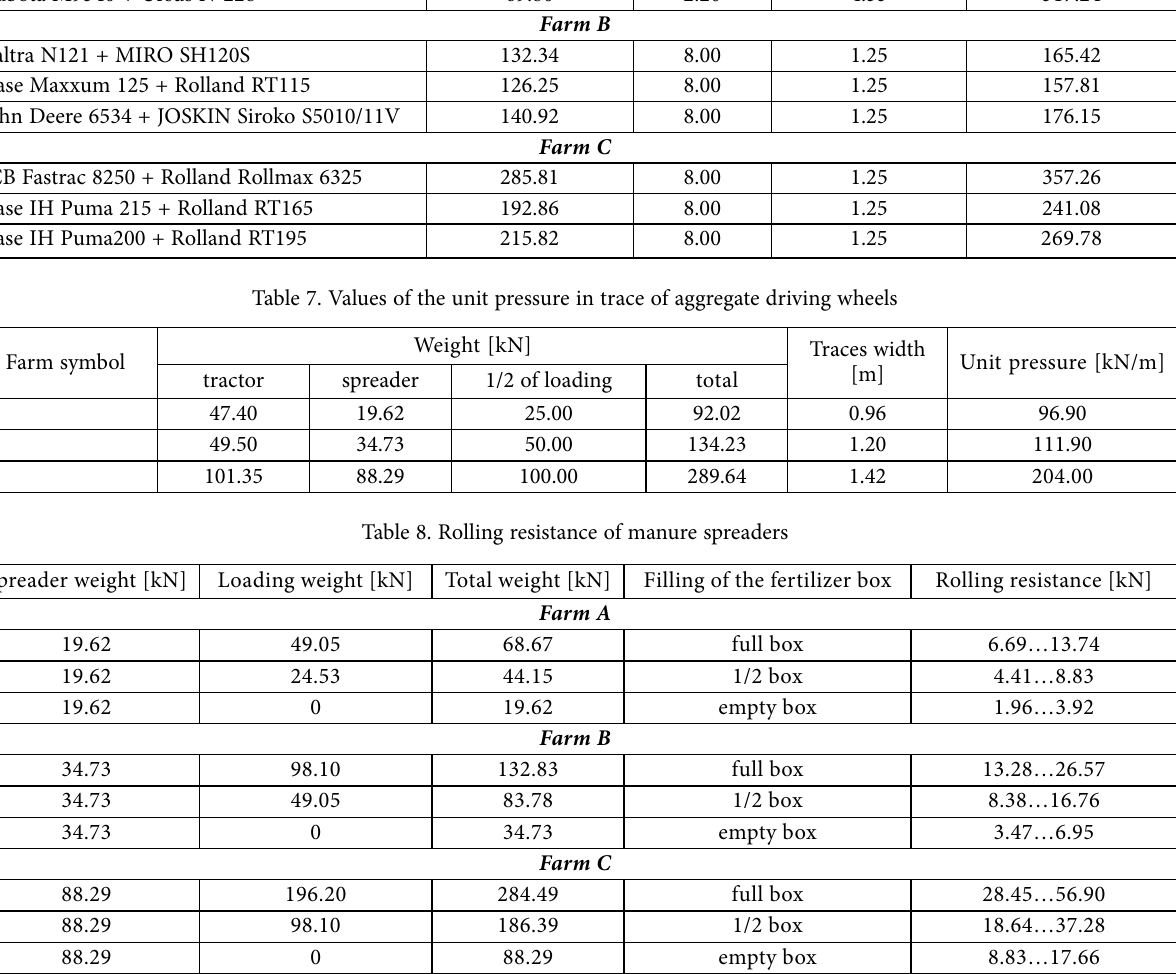
Weight of tractor, Working spreader and half width [m] of loading [kN]